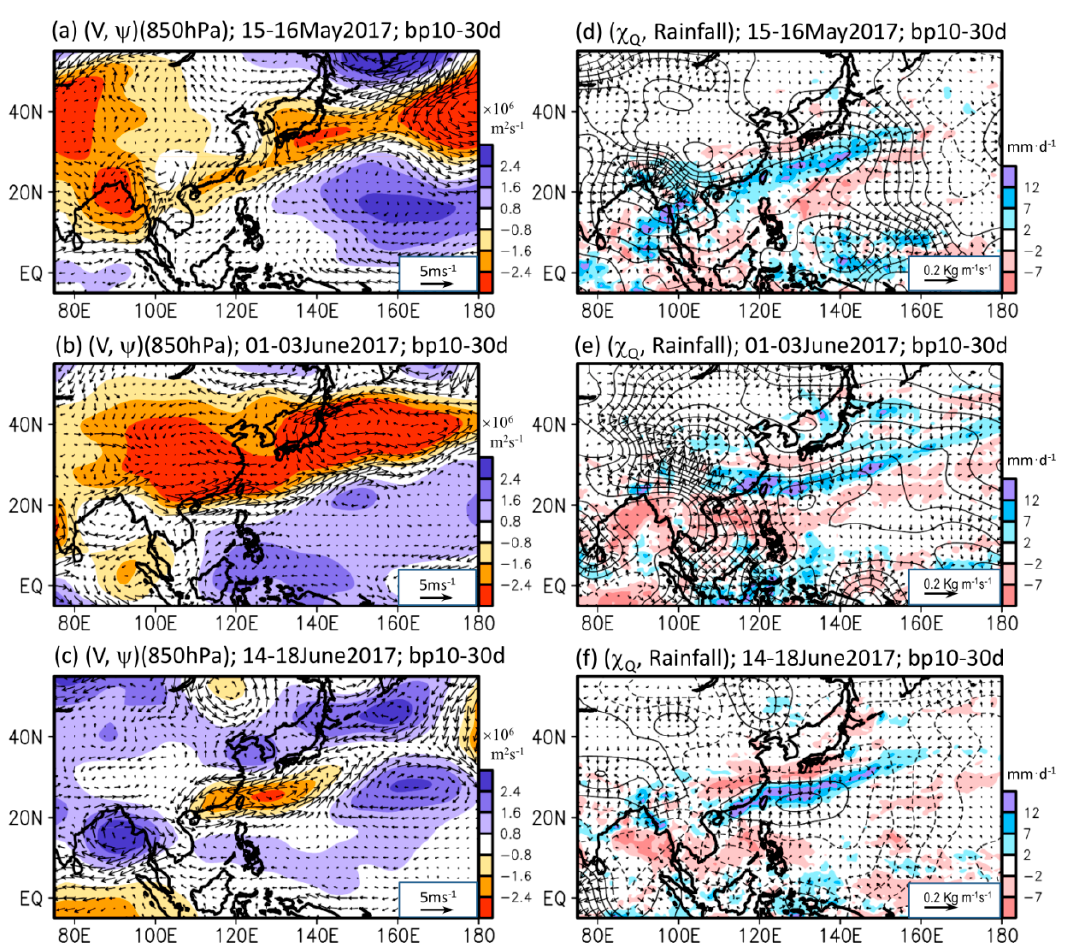
Figure 8. Similar to Figure 6, but for the composite of 10–30 day band pass filtered ψ (shaded) superimposed with related wind vectors at 850 hPa for the three selected events: (a) FR1 (15–16 May 2017), ( b ) FR2 (01–03 June 2017), and (3) FR3 (14–18 June 2017). ( d – f ) corresponds to ( a – c ), respectively, but for the composite of 10–30 day band pass filtered rainfall (shaded) superimposed with χ Q (contour) and related flux vectors.